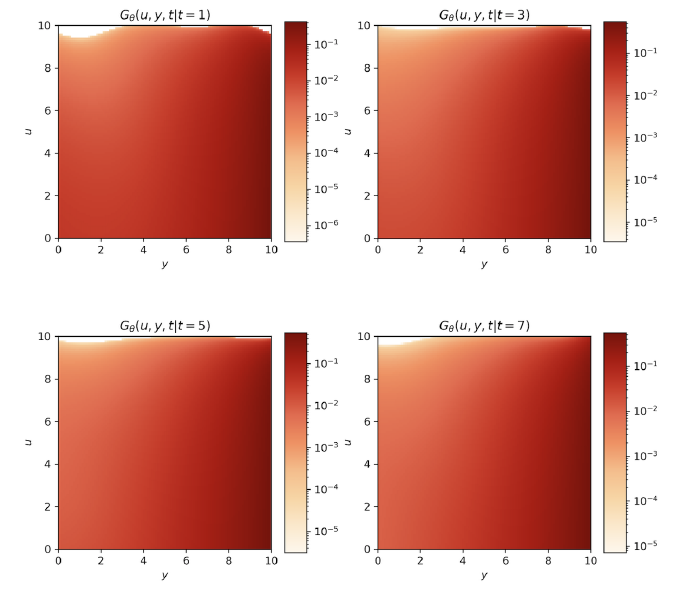
Figure 13. The values of G θ ( u , y , t ) for a given t (Pareto distribution).